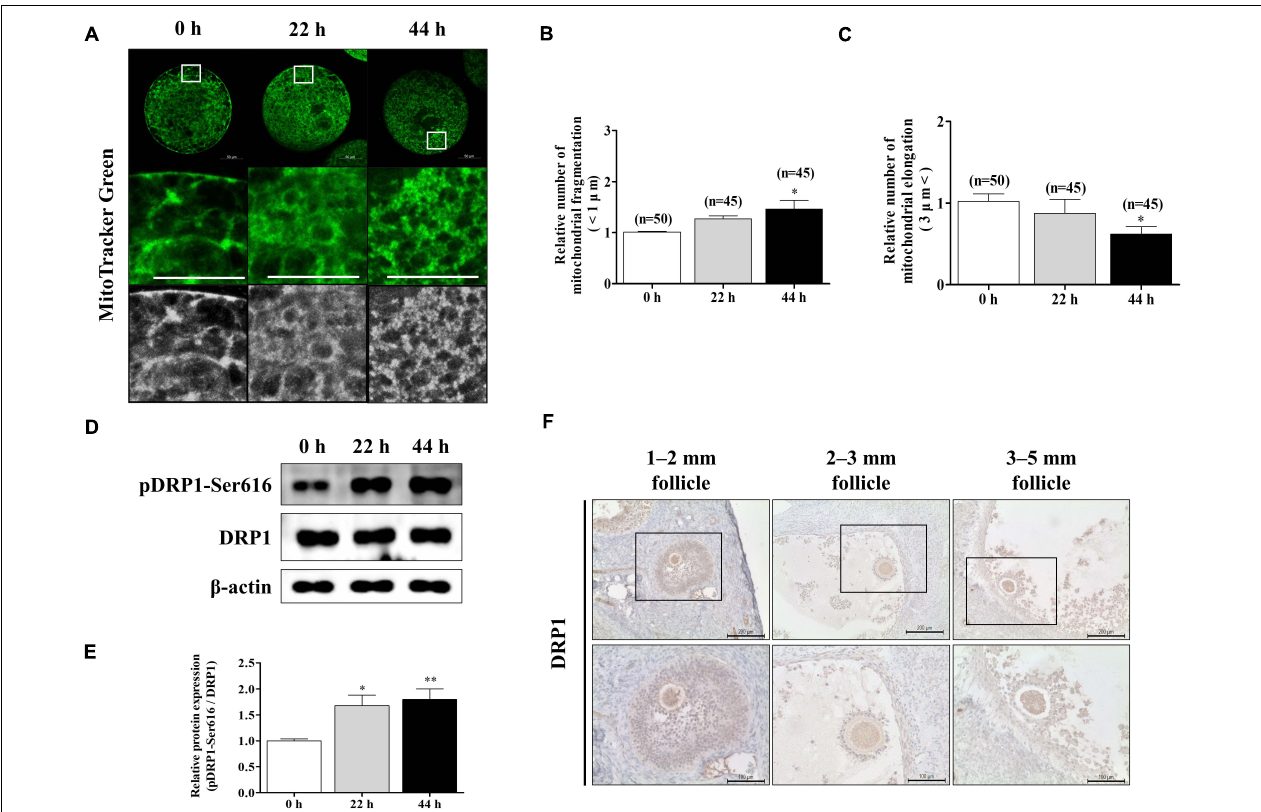
FIGURE 1 | Changes of mitochondrial dynamics during meiotic maturation in porcine oocytes. (A–C) Porcine oocytes during meiotic maturation (0, 22, and 44 h) stained for mitochondrial fragmentation and elongation using MitoTracker green staining. Scale bar: 50 µ m. (D,E) Representative Western blot and quantitative analyses of the expression of mitochondrial fission proteins [dynamin-related protein 1 phosphorylation at serine 616 (pDRP1-Ser616) and dynamin-related protein 1 (DRP1)] in immature and mature oocytes (0, 22, and 44 h). (F) Immunohistochemistry of DRP1 in various porcine ovarian follicles (1–2, 2–3, and 3–5 mm). Scale bar: 100 and 200 µ m. Data in the bar graph represent the mean ± SD/SEM of three independent experiments ( ∗ p < 0.05; ∗∗ p < 0.01). TABLE 2 | Meiotic maturation rate according to Mdivi-1 concentrations. % of oocytes (n) Mdivi-1 ( µ